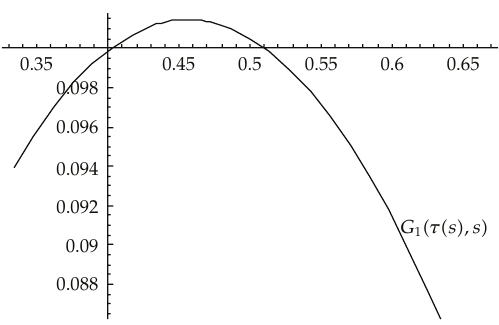
Figure 3: Graph of function G 1 (cid:6) τ (cid:6) s (cid:7) ,s (cid:7) for θ (cid:8) 1 / 3, α (cid:8) 5 /